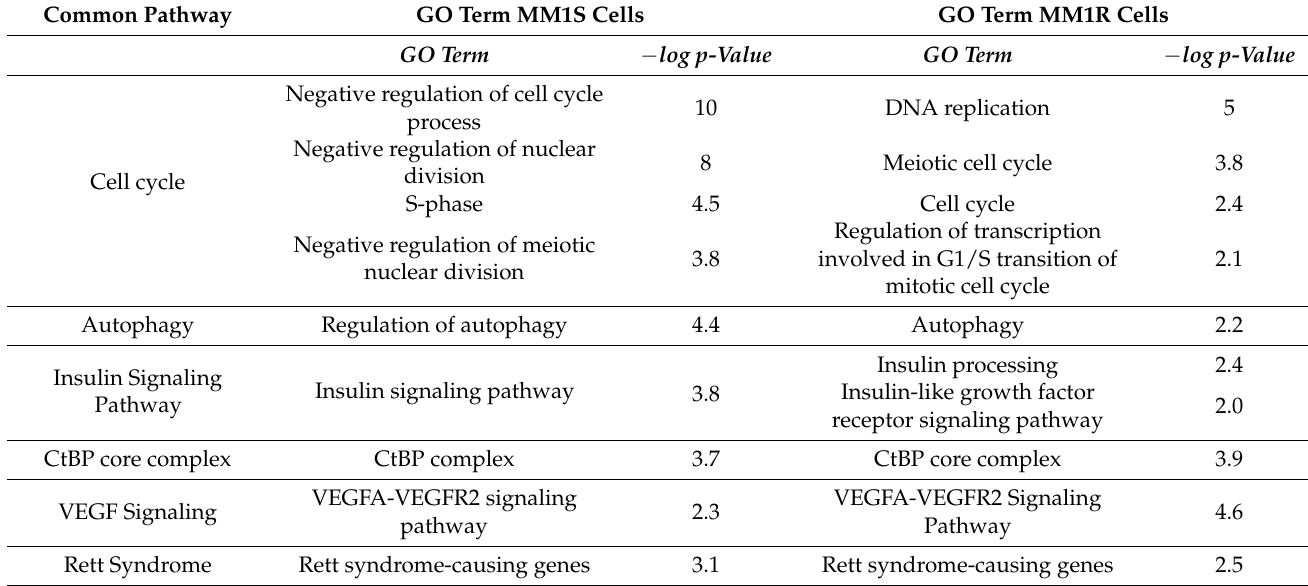
Table 2. Common enriched pathways of significant DMP-related genes between RSL3-treated MM1S and MM1R cells. Common